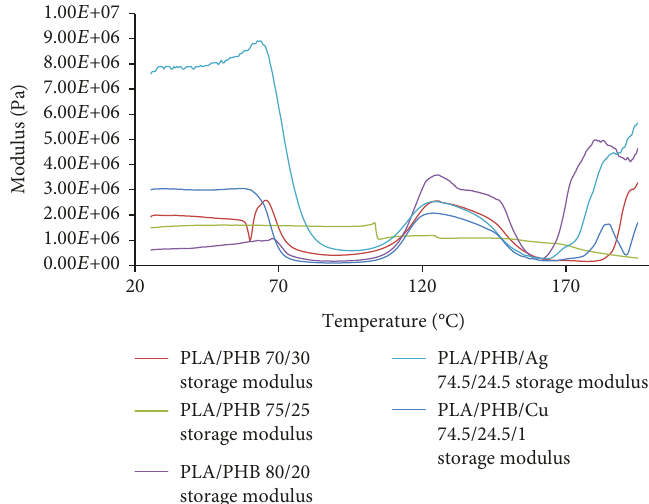
Figure 2: Storage modulus ( G ′ ) against temperature.